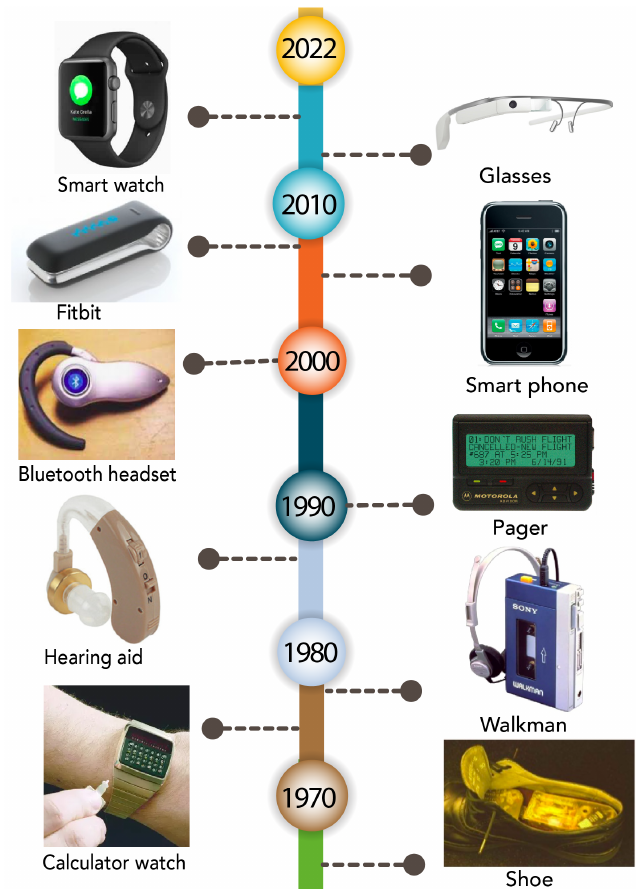
Figure 2. Development of wearable devices during the past 50 years. Starting from 1960s, the first wearable product was a centimeter-scale computer hidden inside shoes. Currently, advanced millimeter-scale systems are embedded on wrist-worn, chest-worn and head-worn